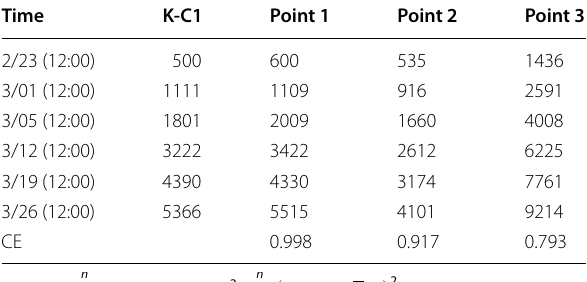
Table 1 Displacement values collected by K‑C1 and calculated for reference points (unit: mm)